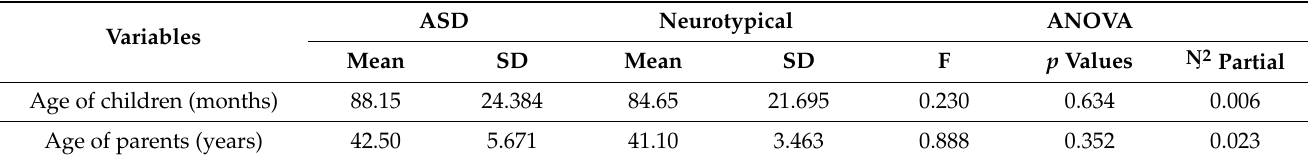
Table 1. Data relating to the analysis of the quantitative variables of both groups.